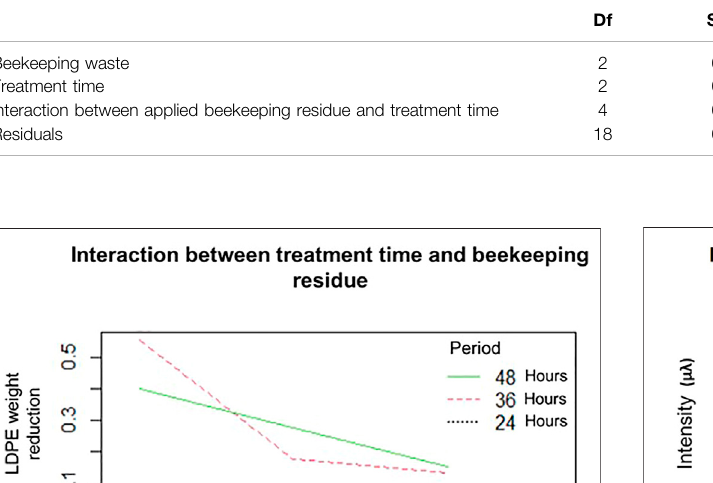
TABLE 1 | Result of analysis of variance (ANOVA for 2 factors).